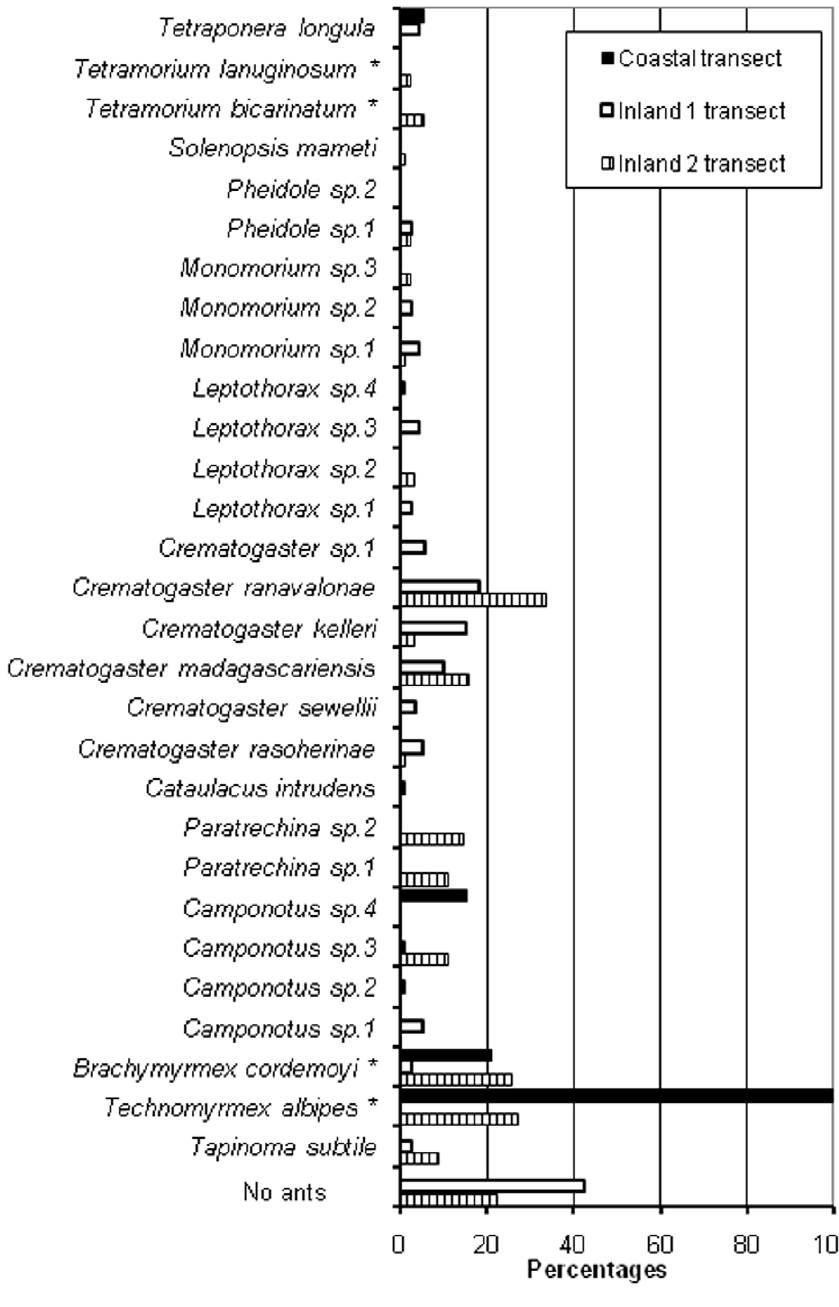
Figure 1. Relative frequency for the 29 ant species recorded in the coastal transect and the two inland transects. Because one tree can shelter several ant species, the total percentages per transect can surpass 100%.* introduced species.